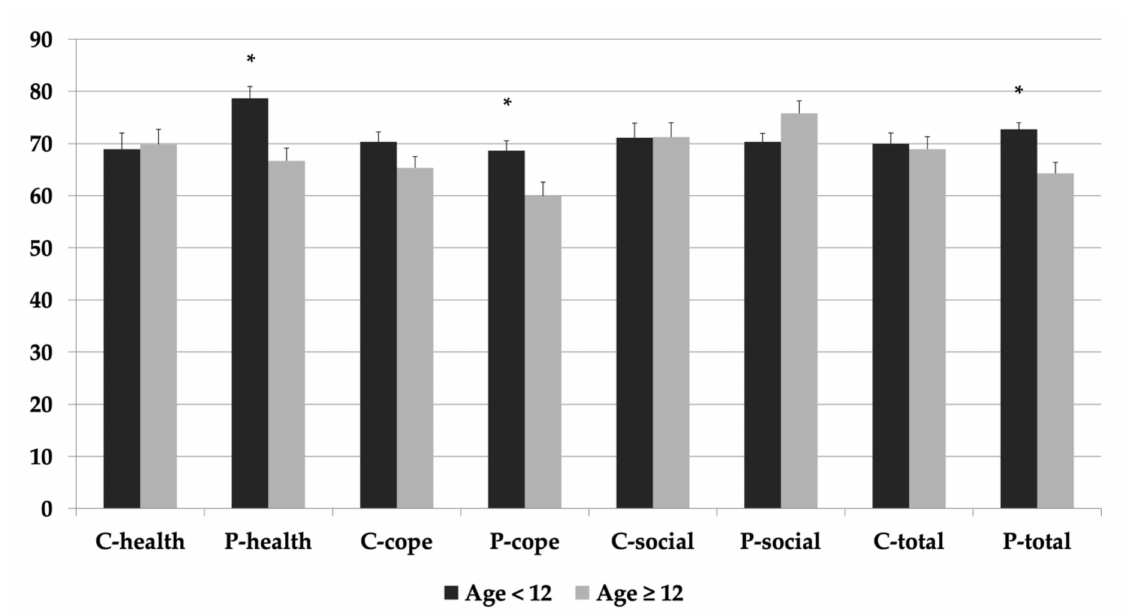
Figure 2. Total and sub-domain scores (Future Health [health], Coping and Adjustment [cope] and Social-Emotional [social]) for both child (C) and parental (P) HRQOL reports for children ≥ 12 and <12 years of age. All values expressed as mean ± standard error. * Significant at p < 0.05.